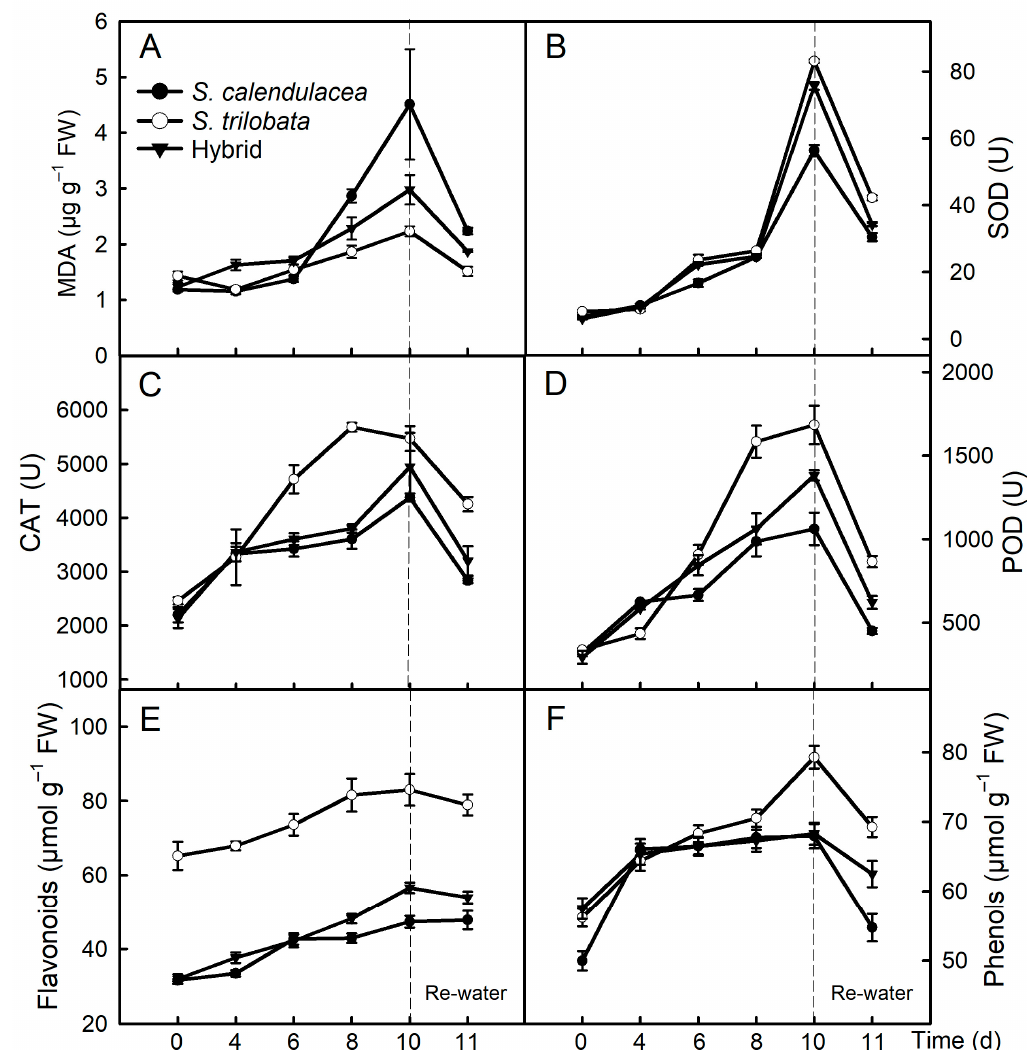
Figure 3. Antioxidant enzyme activity and antioxidant substance content. Changes of the activities of superoxide dismutase (SOD, B ), catalase (CAT, C ), peroxidase (POD, D ) and total antioxidant capacity (TAC, D ), and the contents of malondialdehyde (MDA, A ), flavonoids and phenols ( E , F ) in leaves of S . calendulacea , S . trilobata and their hybrid under drought stress and re-watered.